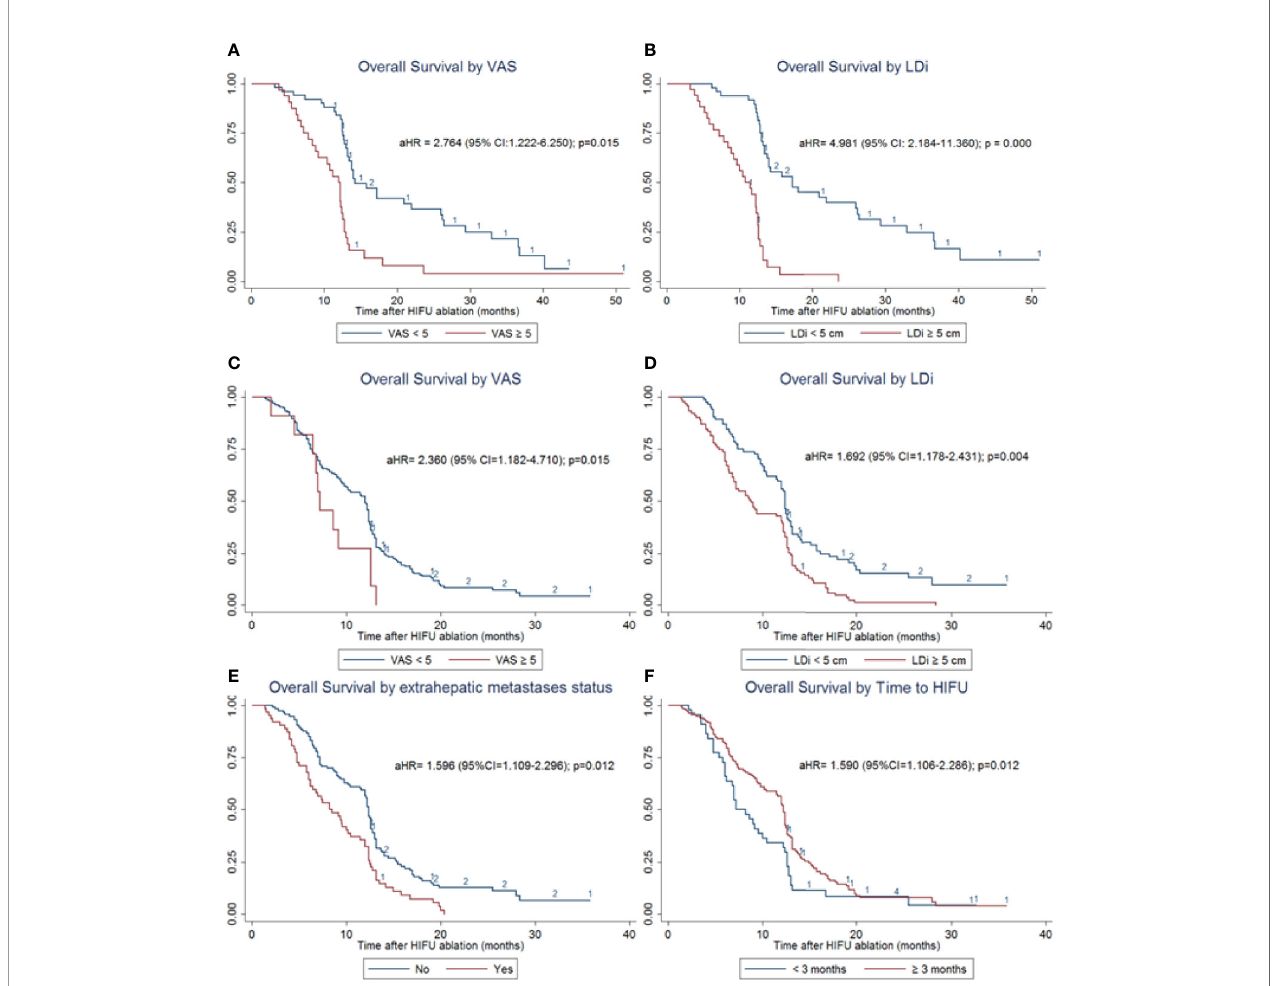
FIGURE 4 | OS subgroup analyses of patients with PLC and MLC. (A) OS strati fi ed analysis by VAS in patients with PLC. VAS ≥ 5 signi fi cantly increases the risk of death [aHR= 2.784 (95% CI = 1.222 – 6.250); p = 0.015]. (B) OS strati fi ed analysis by LDi in patients with PLC. LDi ≥ 5 cm also signi fi cantly increases death risk (aHR = 4.981 (95% CI=2.184 – 11.360); p = 0.000) (C) OS strati fi ed analysis by VAS in patients with MLC. VAS ≥ 5 signi fi cantly increases the risk of death (aHR = 2.360 (95% CI=1.182 – 4.710); p = 0.015). (D) OS strati fi ed analysis by LDi in patients with MLC. LDi ≥ 5 cm also signi fi cantly increases death risk (aHR = 1.692 (95% CI